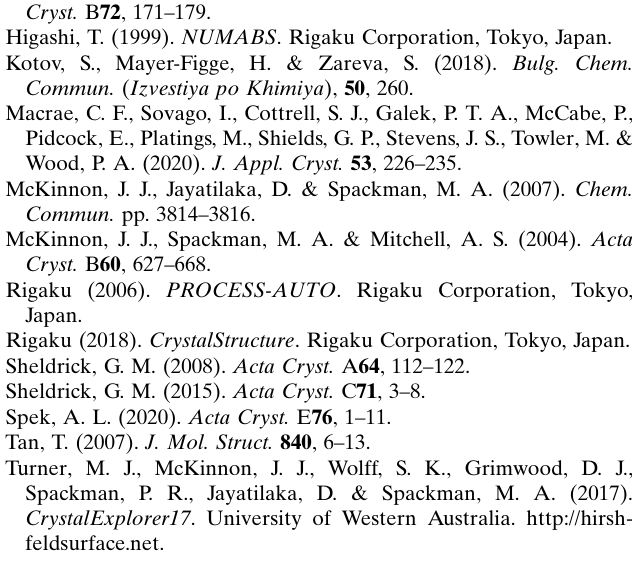
N (cid:2) (cid:2) (cid:2) H (cid:2) (cid:2) (cid:2) O hydrogen bonds were found to be disordered over two positions in difference-Fourier maps. The positional parameters and occupancy factors were refined, with bond- length restraints of N—H = 0.88 (1) A˚ and O—H = 0.84 (1) A˚ , and with U (H) = 1.5 U (N or O); the refined distances iso eq